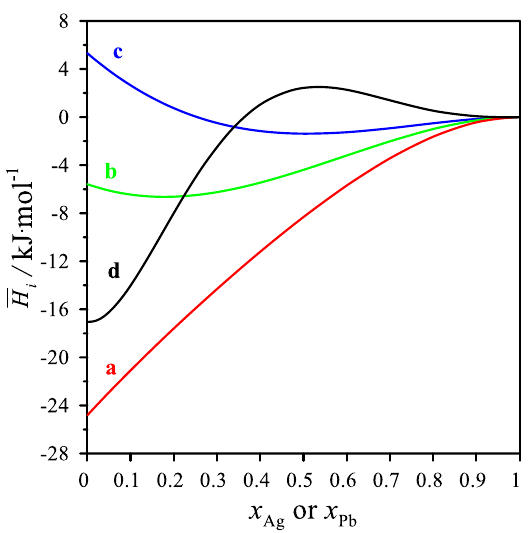
Figure 4. Th e partial molar mixing enthalpy Δ 𝐻 i for the measured intersections. Δ 𝐻 Ag for (a) x Mg / x Pb Figure 4. The partial molar mixing enthalpy ∆ H i for the measured intersections. ∆ H Ag for = 1/3, (b) x Mg / x Pb = 1, (c) x Mg / x Pb = 3 and Δ 𝐻 Pb for the measured intersections (d) x Ag / x Mg = 1/3 at 1116 (a) x Mg / x Pb = 1/3, (b) x Mg / x Pb = 1, (c) x Mg / x Pb = 3 and ∆ H Pb for the measured intersections K. (d) x Ag / x Mg = 1/3 at 1116 K.